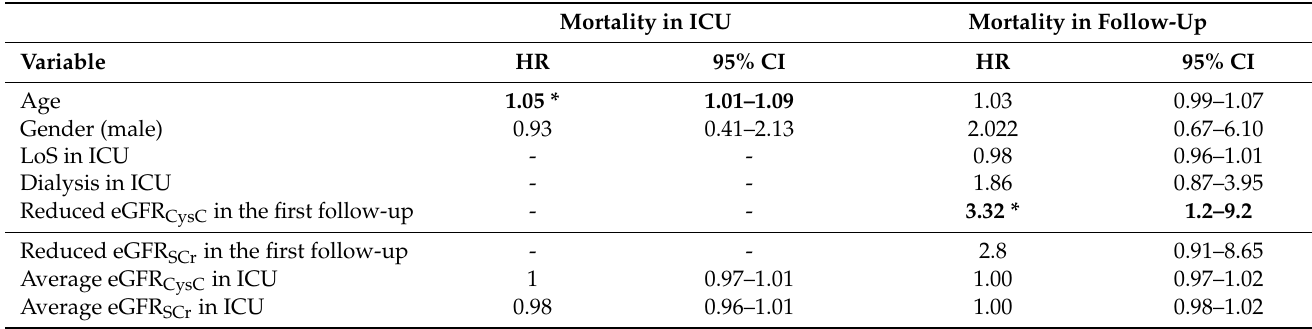
Table 5. Univariate Cox regression models for mortality in ICU and follow-up.